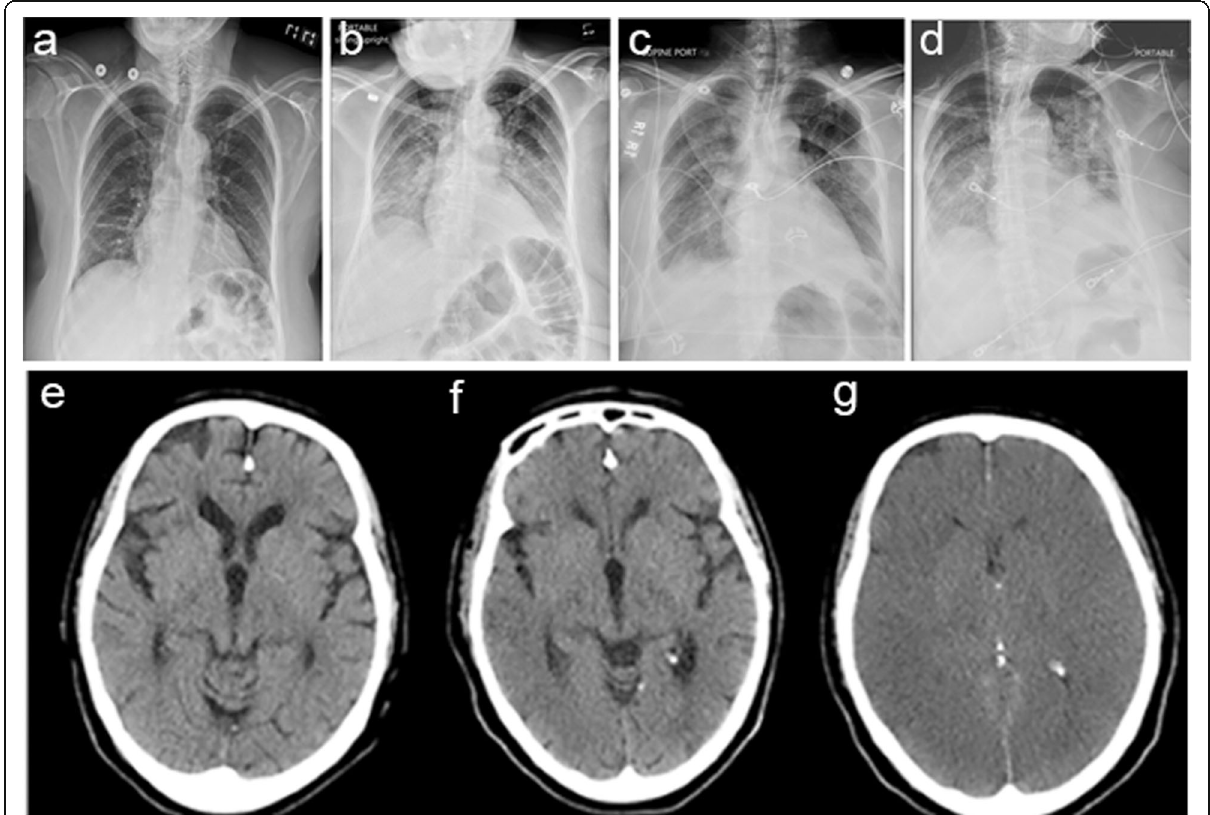
Fig. 2 Periictal chest x-ray (CXR) and head CT (HCT) scan: a CXR on admission; b CXR 10 h prior to the terminal seizure; c CXR 4 h prior to the terminal seizure; d CXR 12 h after the terminal seizure: e HCT 11 h prior to the terminal seizure; f HCT 9 h after the terminal seizure without acute changes; g HCT 12 h after the terminal seizure with diffuse cerebral